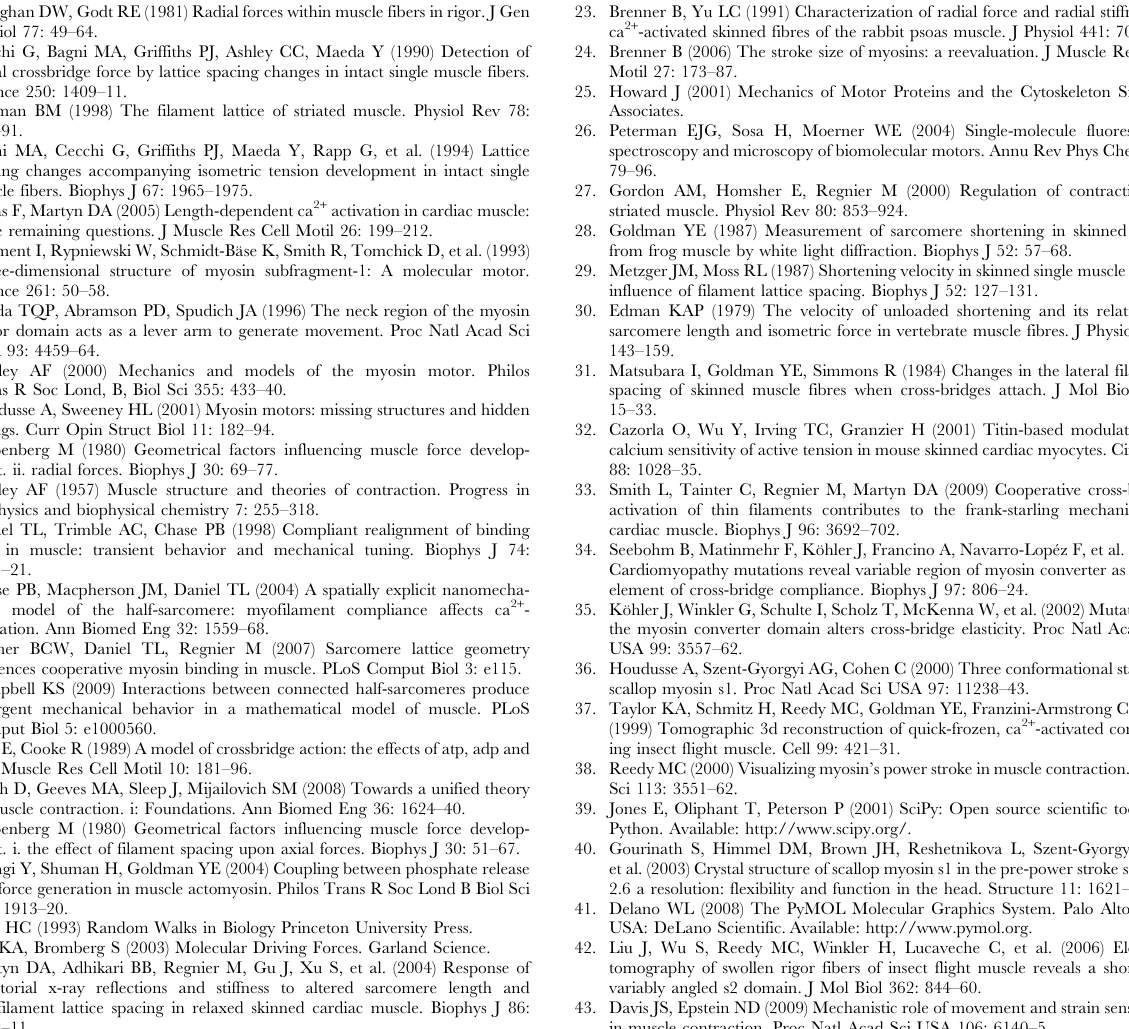
Figure S2 Cross-bridge free energy and kinetics at multiple lattice spacings. (A)–(B) show the free energies of the 4sXB and the 2sXB models at lattice spacings between 30 and 38 nm. (C)–(H) show the kinetic rate constants of the 4sXB and the 2sXB models at lattice spacings between 30 and 38 nm. Each rate is a section taken from the corresponding display in Figure 3. Found at: doi:10.1371/journal.pcbi.1001018.s002 (0.24 MB